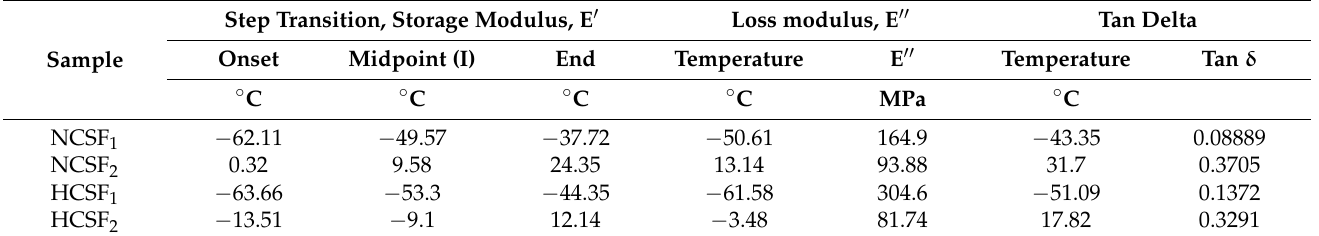
Table 8. DMA analysis